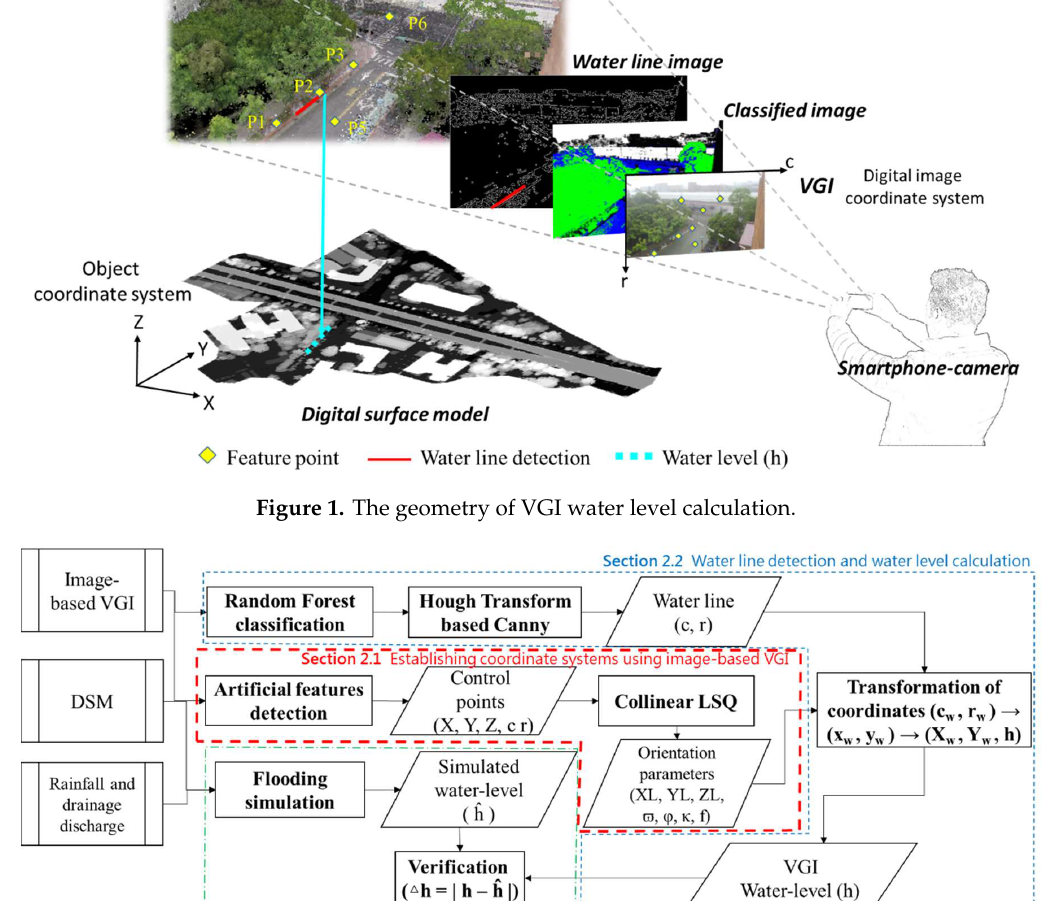
Figure 1. The geometry of VGI water level calculation.